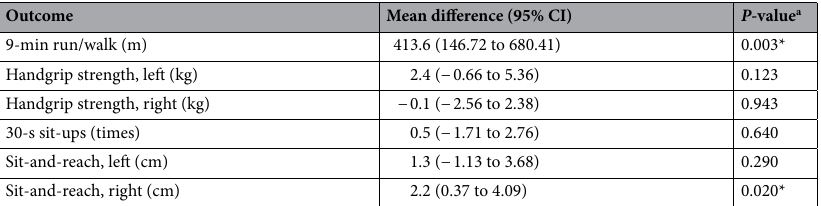
Outcome Mean difference (95% CI) P -value